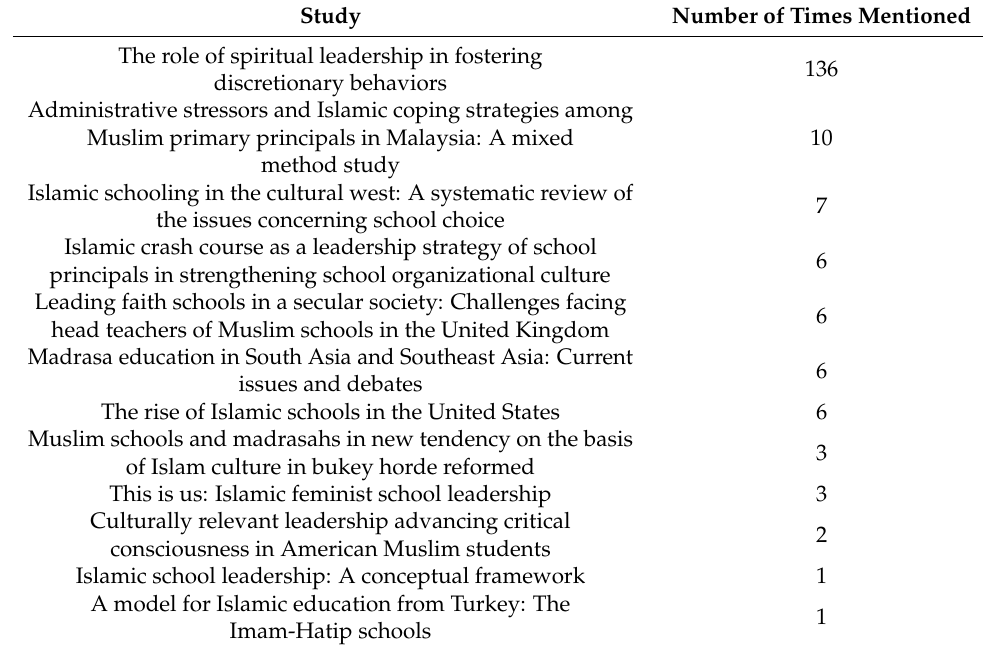
Table 2. Number of times “spiritual” was mentioned in each study.